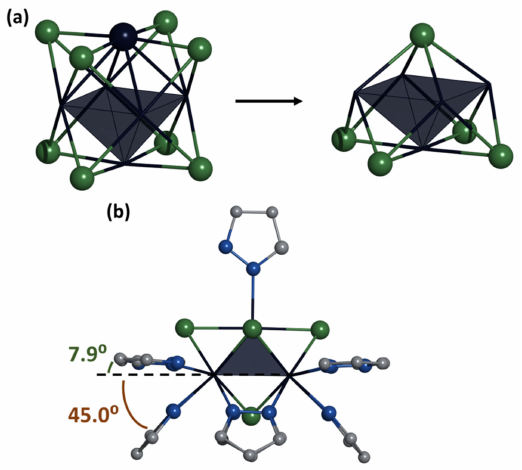
Figure 3. ( a ) Comparison of cluster cores {Mo 6 ( µ 3 -Se) i 8 } 0 and {Mo 5 ( µ 3 -Se) i 4 ( µ 4 -Se) i } 5+ . ( b ) Side view of cluster cation [{Mo 5 ( µ 3 -Se) i 4 ( µ 4 -Se) i ( µ -pz) i 4 }(pzH) t 5 ] + , demonstrating angles between inner or terminal ligands and base of pyramid. Hydrogen atoms are omitted for clarity. Color code: Mo—dark blue, Mo 5 —dark blue square pyramid, Se—green, C—gray,